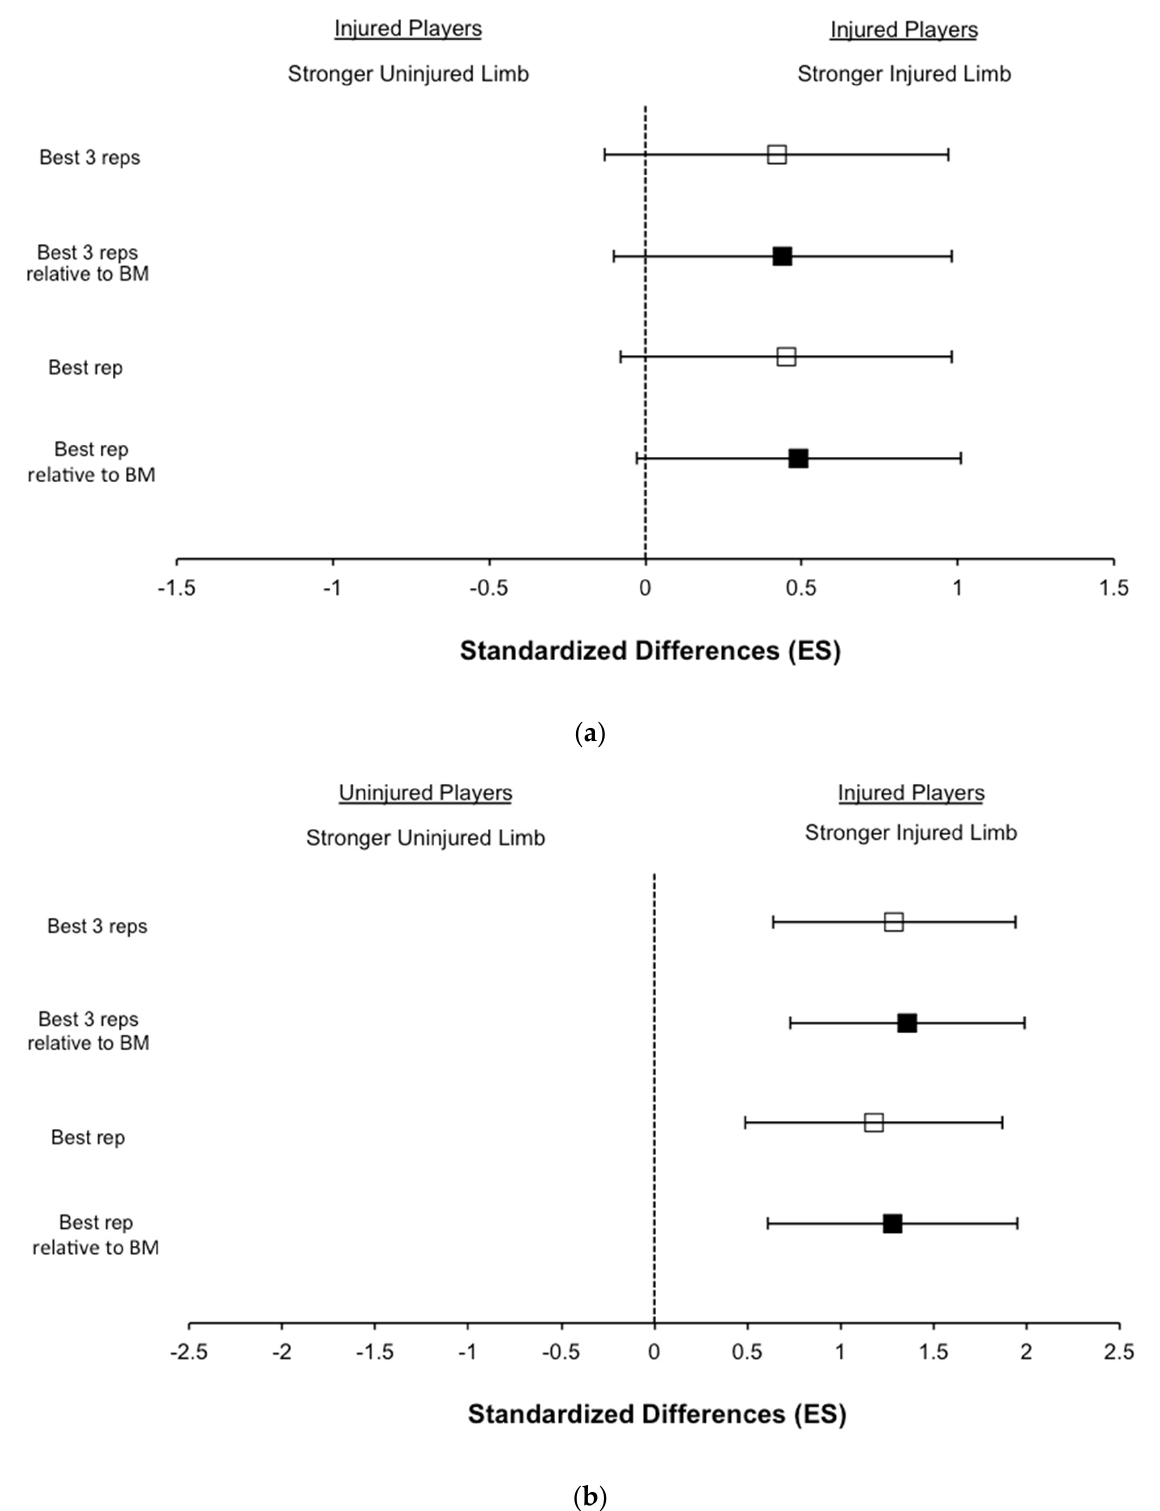
Figure 1. Standardized differences in knee flexor eccentric strength assessed with a Nordic hamstring exercise. ( a ) Comparisons between the injured limbs vs. uninjured limbs among players with a prior hamstring injury, ( b ) Comparisons between the injured limbs of players with a prior hamstring injury vs. all uninjured limbs among the uninjured players.